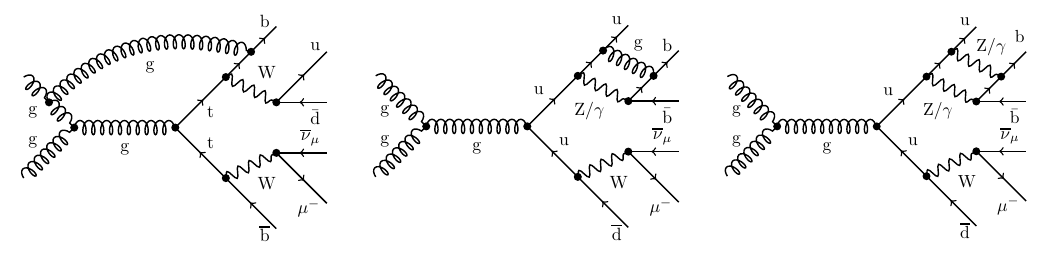
Figure 3. Sample one-loop Feynman diagrams contributing to gg NLO. While some diagrams can be uniquely identi(cid:12)ed as QCD corrections (left) or EW corrections (right), this is not possible for others